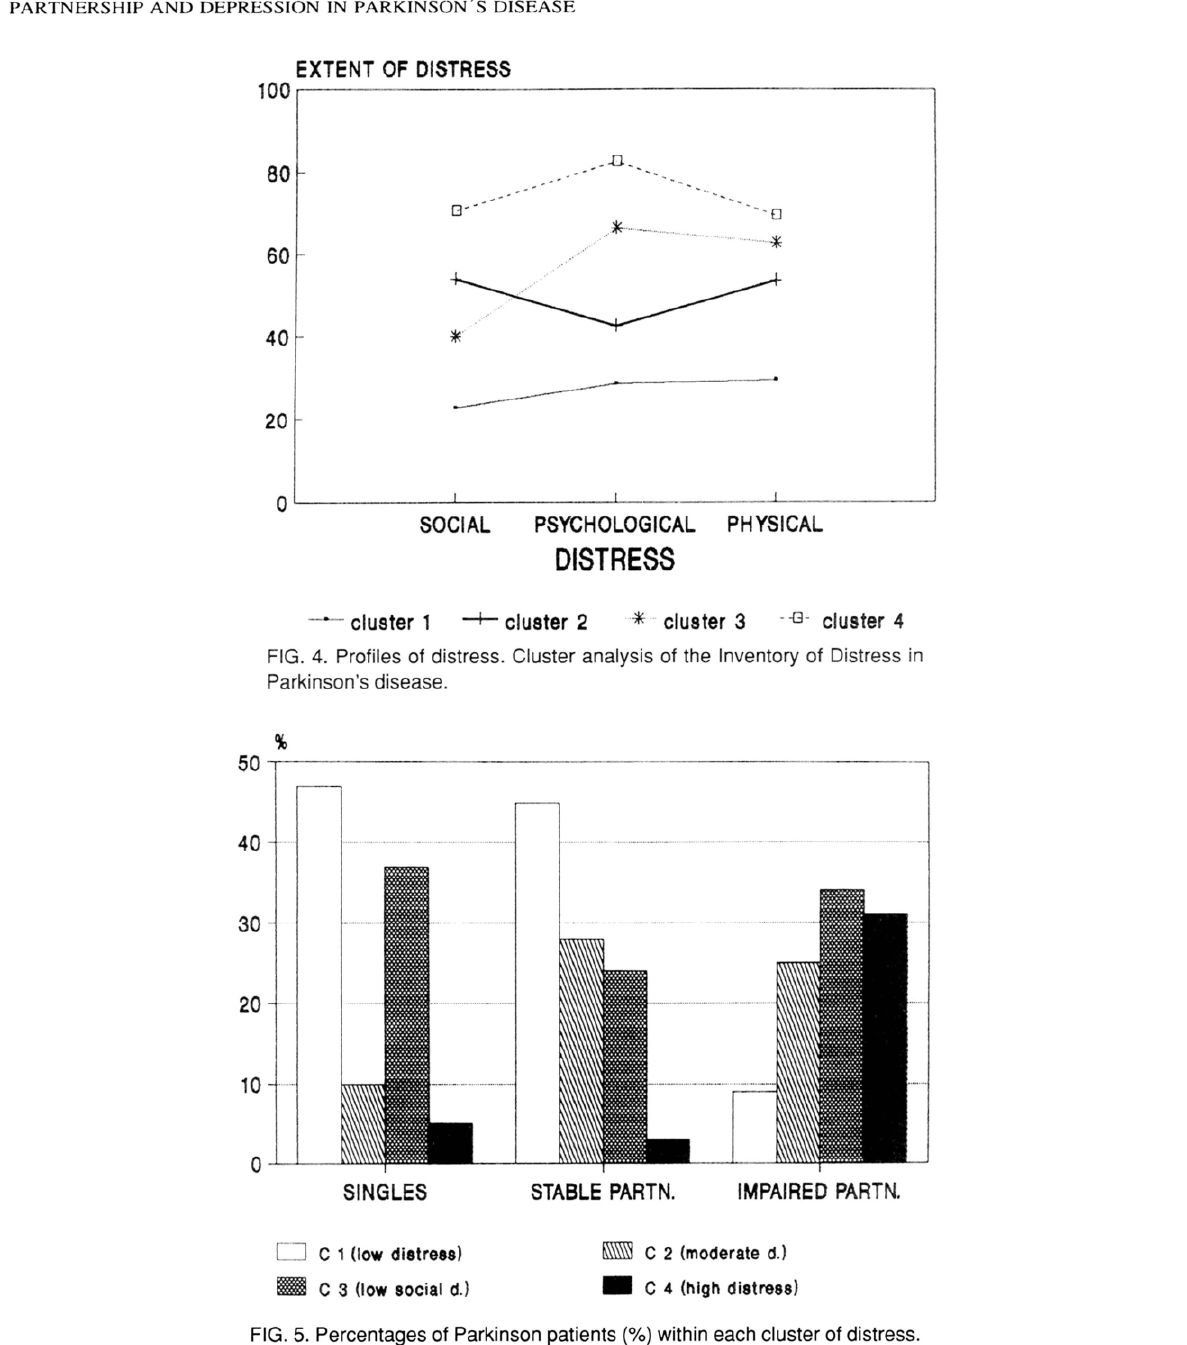
FIG. 5. Percentages of Parkinson patients (%) within each cluster of